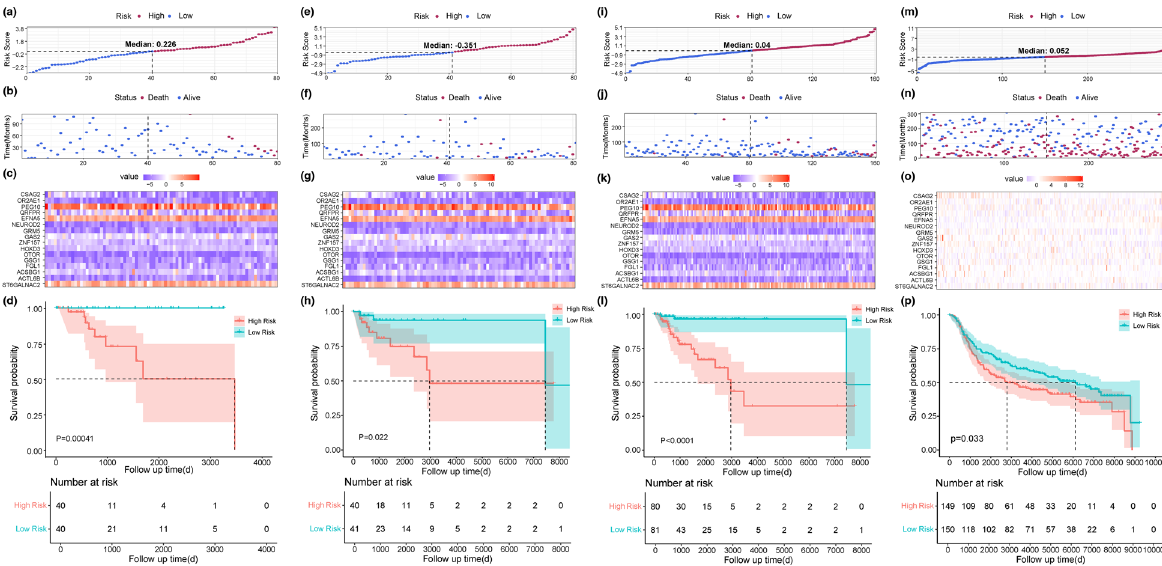
Figure 2: Evaluation and validation of the 16 - gene model in TNBC. Distribution of risk score based on the 16 - gene model in the training set ( a ) , the testing set ( e ) , the entire TCGA – TNBC cohort ( i ) , and the METABRIC – TNBC cohort ( m ) . Patterns of survival status and survival time of each patient in the training set ( b ) , the testing set ( f ) , the entire TCGA – TNBC cohort ( j ) , and the METABRIC – TNBC cohort ( n ) . Expression pattern of 16 genes of each patient in the training set ( c ) , the testing set ( g ) , the entire TCGA – TNBC cohort ( k ) , and the METABRIC – TNBC cohort ( o ) . Kaplan – Meier survival curves of the OS of patients in the high - and low - risk groups in the training set ( d ) , the testing set ( h ) , the entire TCGA – TNBC cohort ( l ) , and the METABRIC – TNBC cohort ( p )